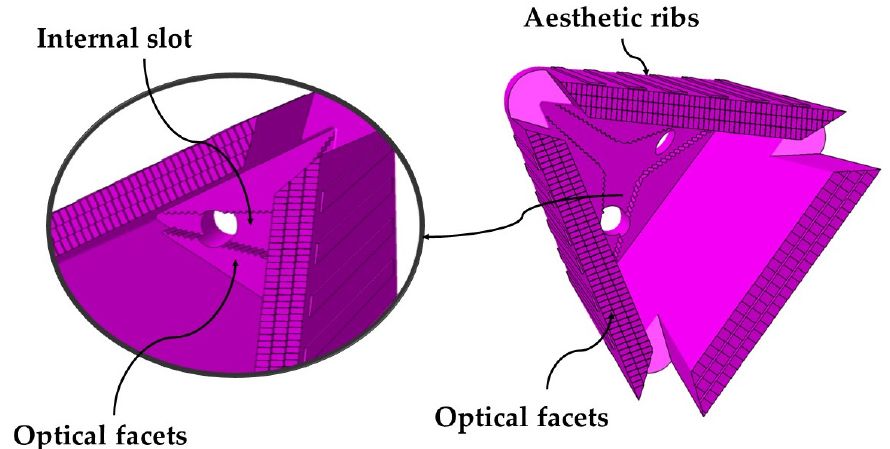
Figure 3. Geometric details of the internal area of the optical piece.